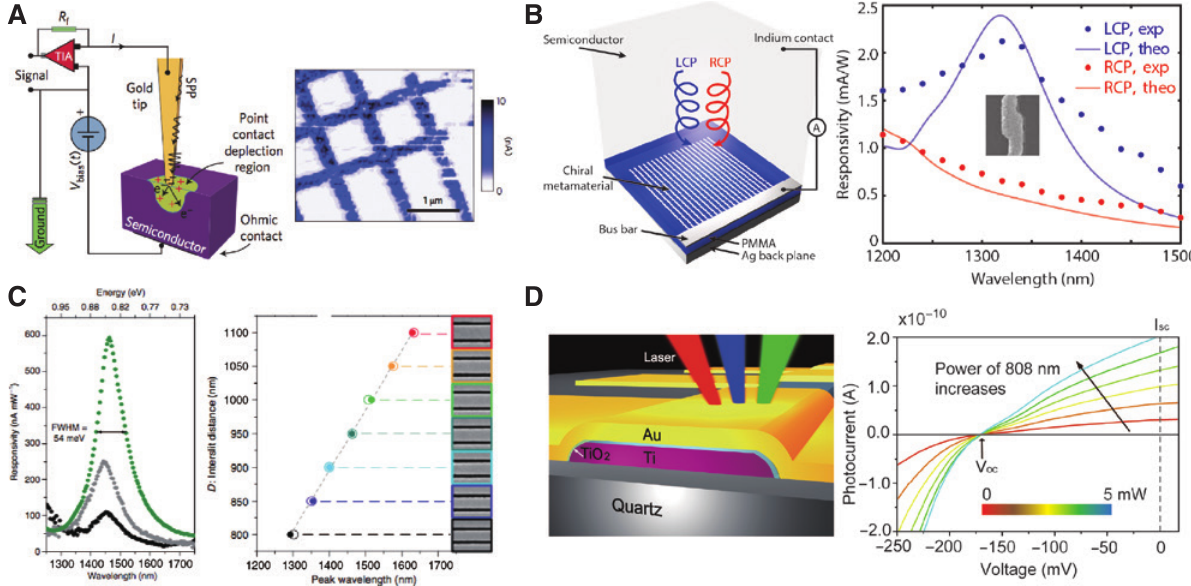
Figure 6: Hot electron-enabled novel detection functionalities. (A) Left: Schematic of hot electron nanoscopy. The gold taper adiabatically compresses the SPPs, providing hot electrons with momentum perpendicular to the semiconductor surface. Right: Hot electron map generated by the nanotaper. (B) Left: Schematic of a circularly polar- ized light detector combining a silver chiral metamaterial and silicon. Right: Experimentally measured responsivity spectrum for left and right hand circularly polarized light. (C) Left: Narrowband responsivity spectrum of a plasmonic grating-based hot electron detector. Right: The responsivity peak position shows a linear dependence on the interslit distance. (D) Left: Schematic of a MIM diode for wavelength determination. Right: Photocurrent under bias and 808 nm illumination at different powers showing constant open-circuit voltages. Figures adapted with permission from: (A) Ref. [95], ©2013 Nature Publishing Group; (B) Ref. [49], ©2015 Nature Publishing Group; (C) Ref. [46], ©2013 Nature Publishing Group; (D) Ref. [47], ©2013 Nature Publishing